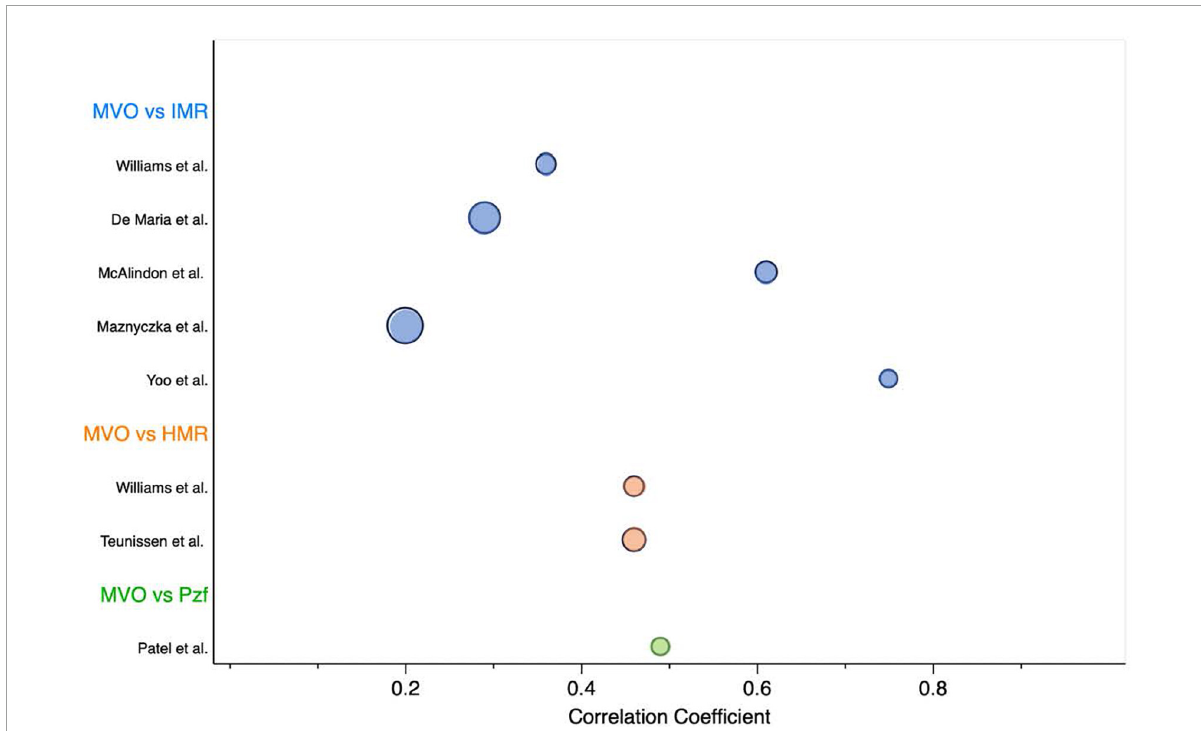
FIGURE5 Overview of studies evaluating the correlation coefficient between MVO by CMR and invasive microvascular resistance indices. Bubble chart sized according to the sample size of each study. HMR, hyperemic microvascular resistance; IMR, index of microvascular resistance; MVO, microvascular obstruction; Pzf, pressure at zero